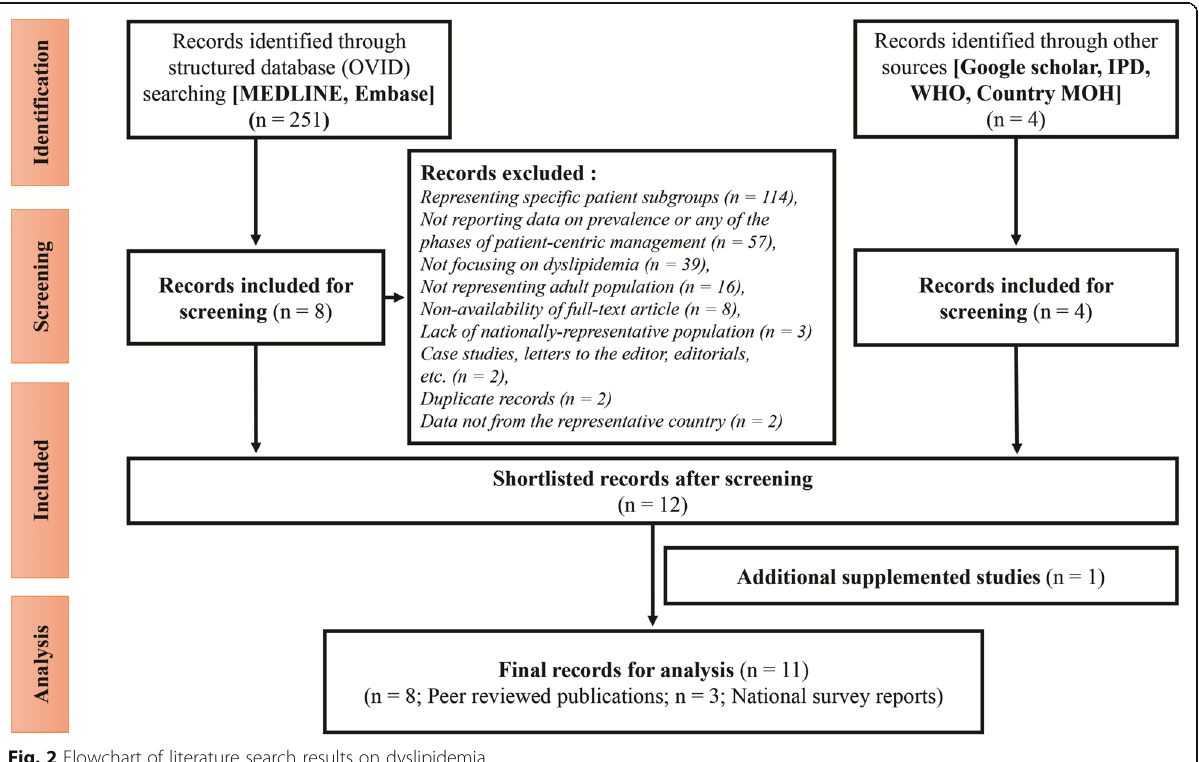
Fig. 2 Flowchart of literature search results on